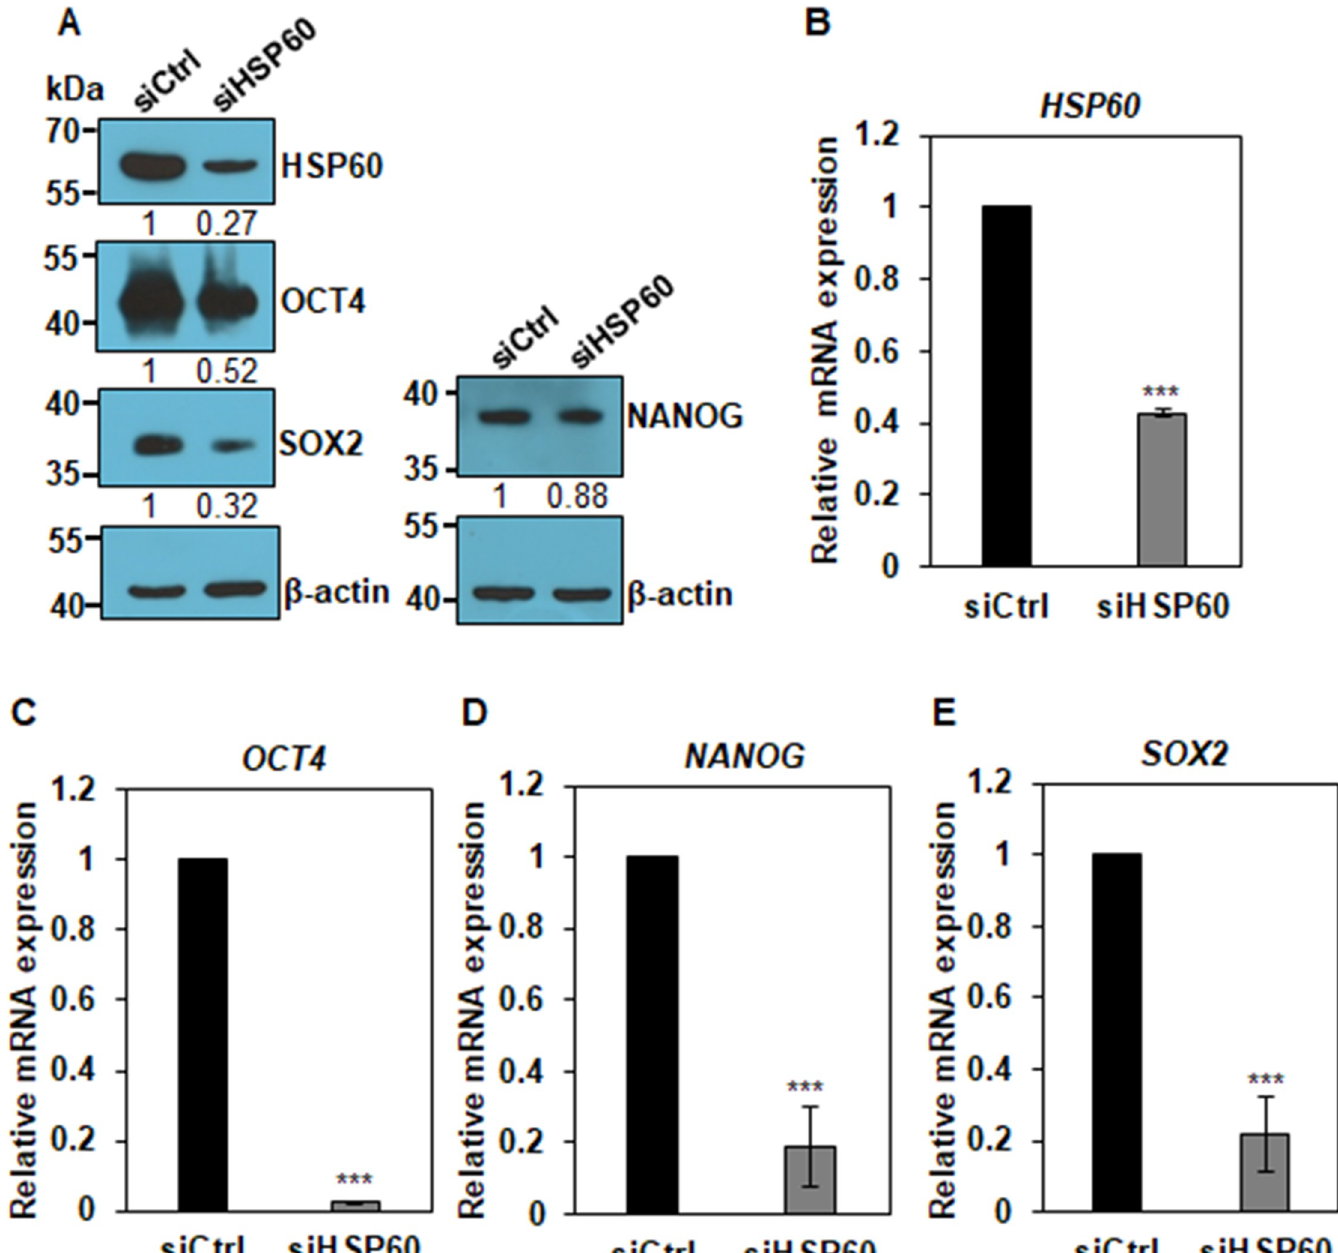
Fig 5. Knockdown effects of HSP60 in primed hPSCs. (A) Cell lysates from HSP60 siRNA-transfected H9 hPSCs were subjected to Western blot analysis with antibodies against HSP60, OCT4, SOX2, and NANOG. Relative protein levels were measured using ImageJ software and normalized to the β -actin. (B) qPCR analysis for the expression of HSP60 and pluripotency genes ( OCT4 , SOX2 , and NANOG ) in control (siCtrl) or HSP60 siRNA-transfected H9 hPSCs (siHSP60). Relative mRNA levels were measured by qPCR and were shown after normalization against GAPDH mRNAs. The graphs represent the mean values of at least two independent determinations ± SD ( ��� , p <